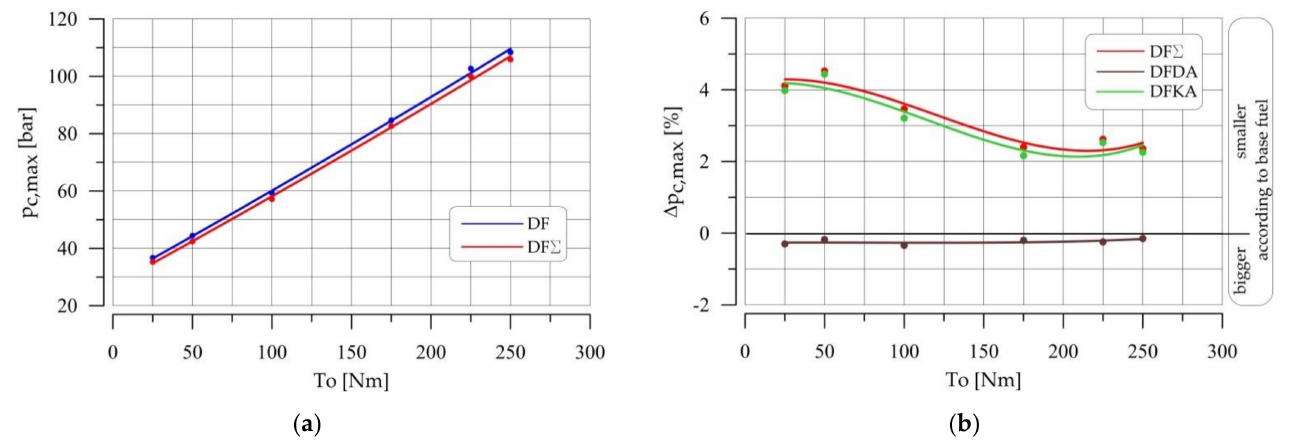
Figure 20. ( a ) Maximum pressure in cylinder vs. engine torque; ( b ) Percentage difference of maximum pressure in cylinder vs. engine torque in relation to the base